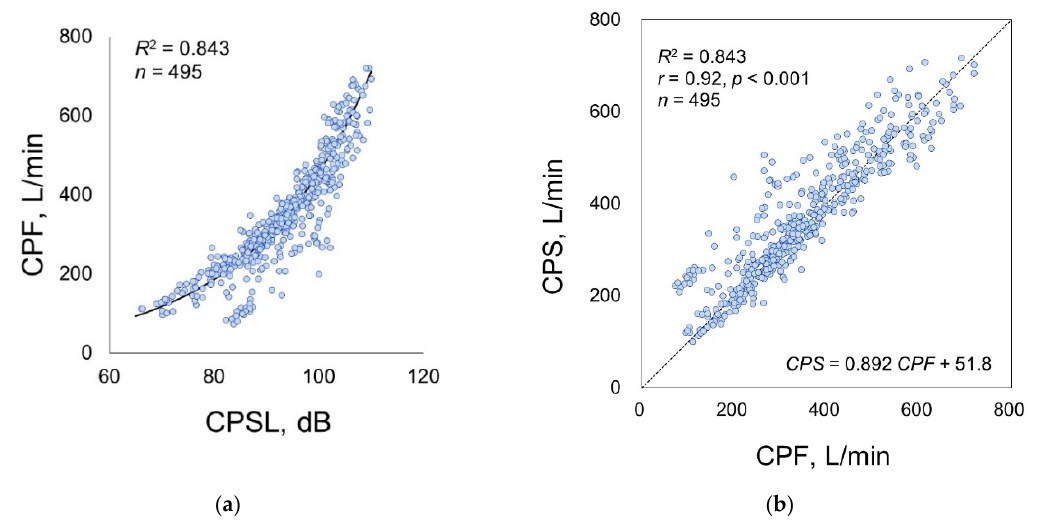
Figure 3. Accuracy of the CPF estimation model using cough sounds. ( a ) Relationship of CPF and CPSL. CPF, cough peak flow; CPSL, cough peak sound pressure level. ( b ) Relationship of CPS and CPF. CPS, cough peak flow predicted via cough sounds. Modified from Umayahara Y: Estimation of cough peak flow using cough sounds, Sensors, 2018 [56] .